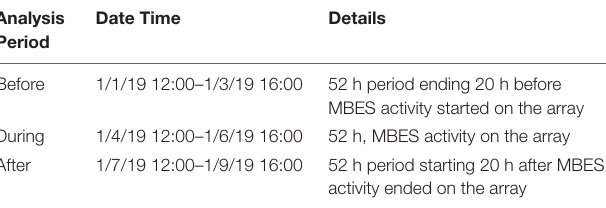
TABLE 3 | Analysis period times and details of the 2019 data set.